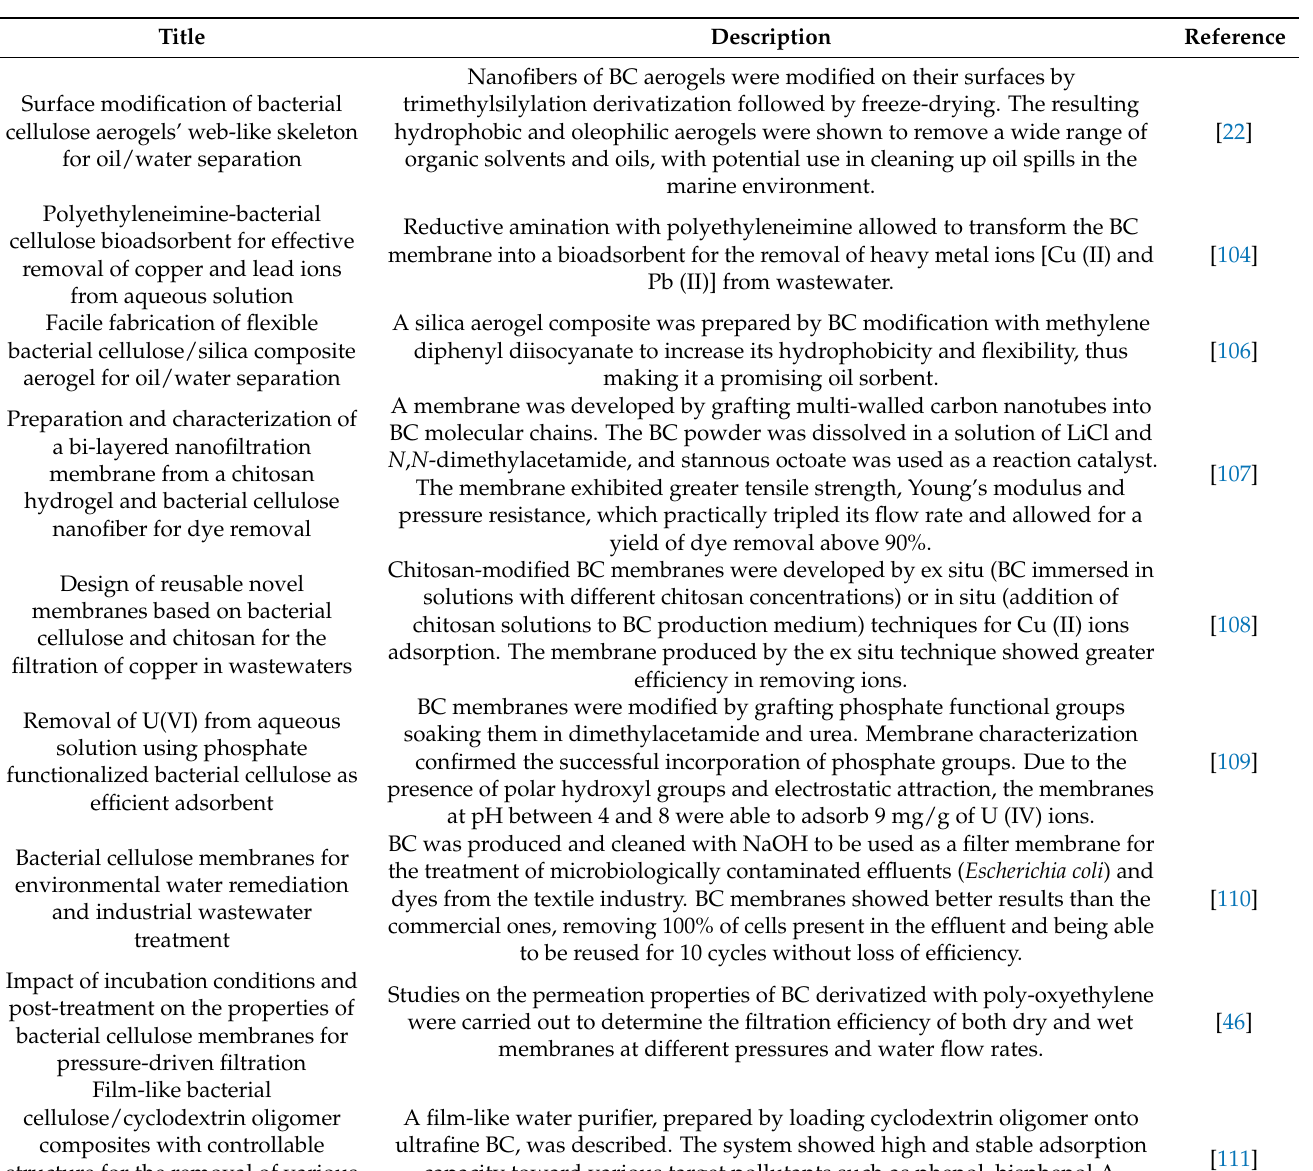
Table 3. Studies relating to the use of bacterial cellulose (BC) as filter membrane to treat